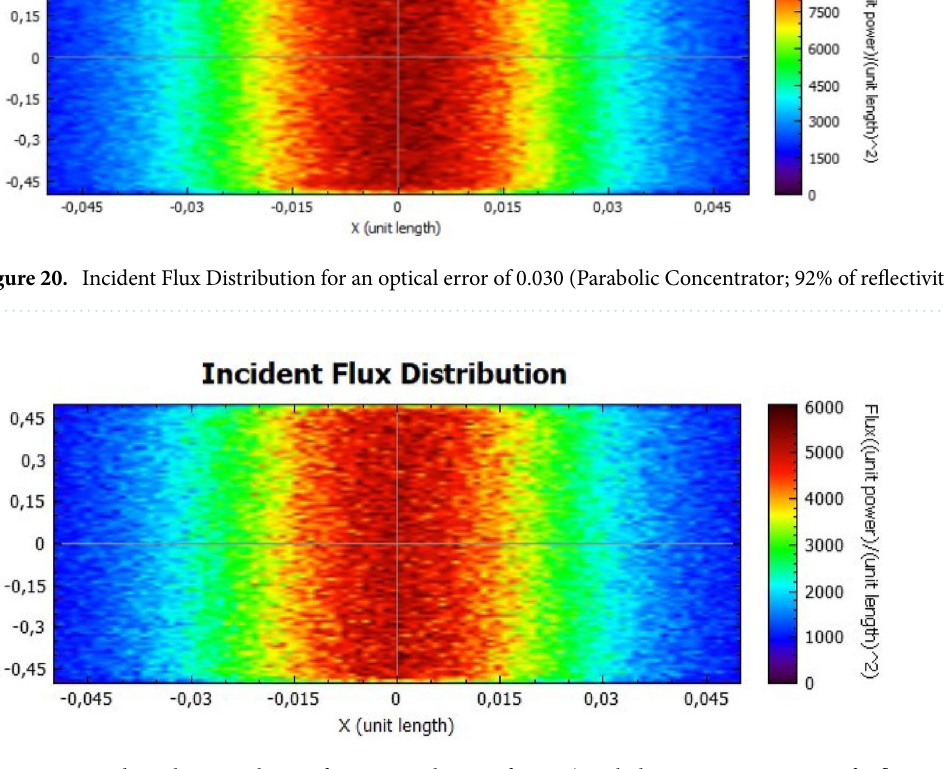
Figure 21. Incident Flux Distribution for an optical error of 0.030 (Parabolic Concentrator; 47% of reflectivity).